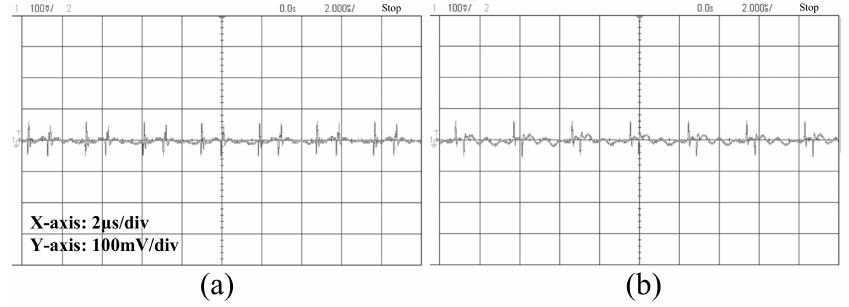
Figure 13. The output voltage ripple under ( a ) 0.5 A load and ( b ) full load.